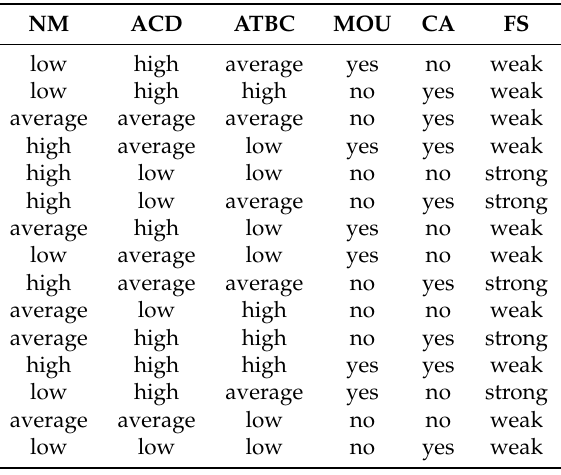
Table 2. A sample of the training data used in this